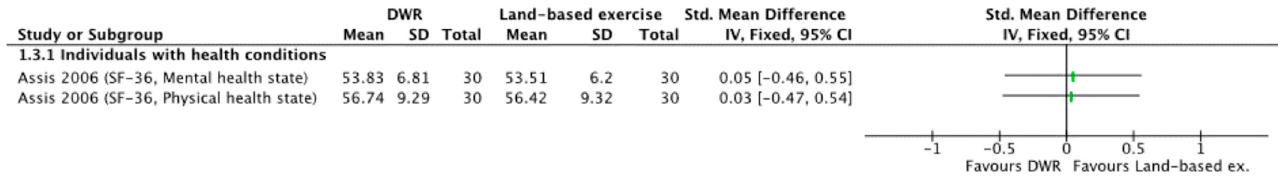
Figure 7. Standardized mean difference (95% CI) for the effect of DWR compared with land trainings on QoL [22].